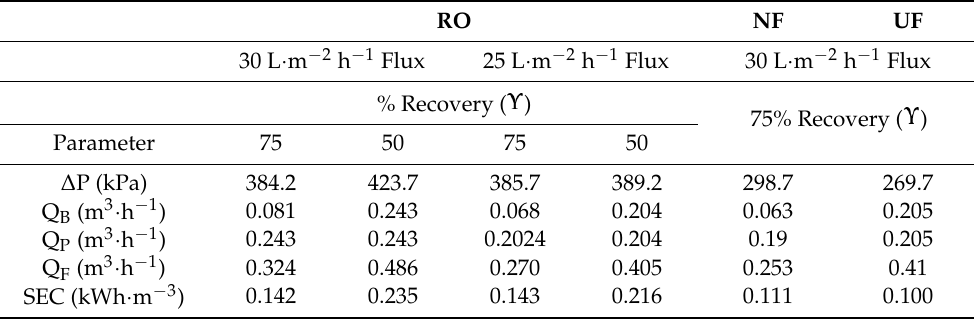
Table 4. Energy consumption comparison of RO membrane operating conditions with NF and UF membranes.